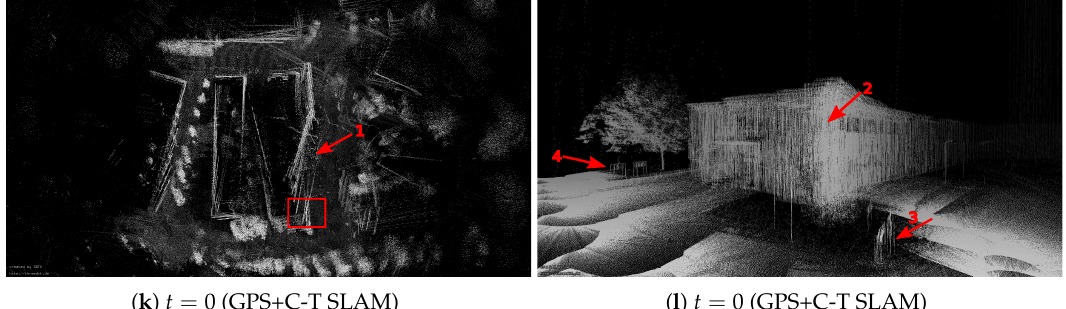
Figure 7. HectorSLAM + C-T SLAM and curvefusion + C-T SLAM denote HectorSLAM and curvefusion are first fed into the continuous-time SLAM. Then the output trajectories are used to unwind the data of the Riegl VZ-400. GPS + C-T SLAM has a similar